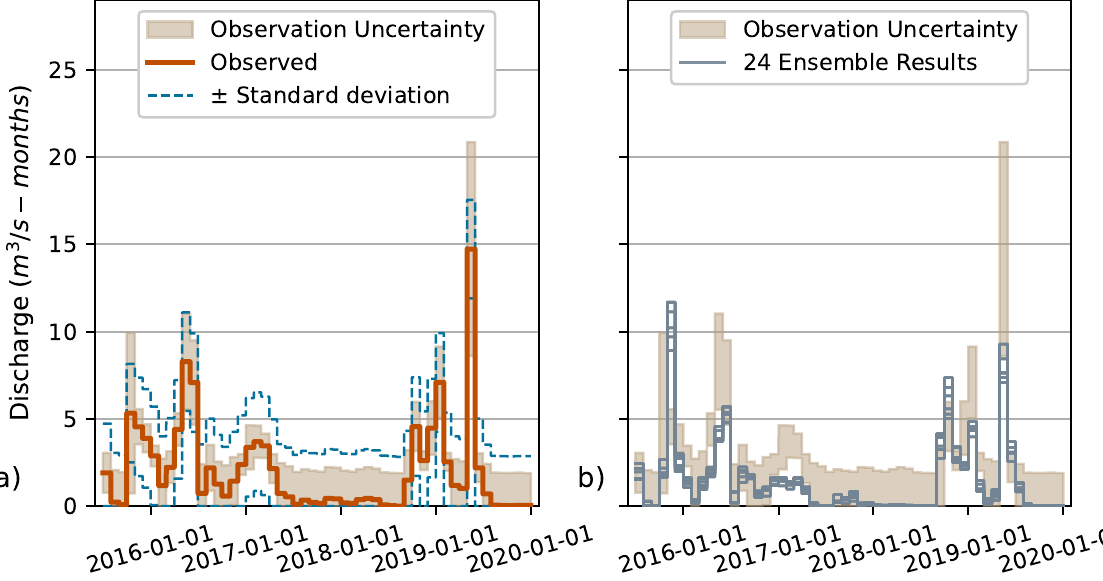
Figure 6. PESTPP-IES uncertainty analysis results for 8158700. Panel ( a ) displays observed discharge along with observation uncertainty descriptions. Observation uncertainty is the RMSE estimated for each month as described in Section 2.3, or the expected uncertainty envelope. The standard deviation of observed discharge is displayed for comparison with the expected uncertainty envelope, and ± standard deviation provides an independent estimate of observation uncertainty. The expected uncertainty envelope is tighter, or narrower, relative to the standard deviation envelope at low and medium discharges and is larger at high discharges. Panel ( b ) displays simulated discharges from 24 best-fit, parameter ensembles. These 24 best-fit ensembles achieve a Φ threshold that identifies the overall best-fit parameter ensembles and produce Σ NK values ranging from 1.00 to 1.24. In Table 6, Σ NK for 8158700 ranges from a minimum of 1.00 to a maximum of 1.14 with an average of 1.08.